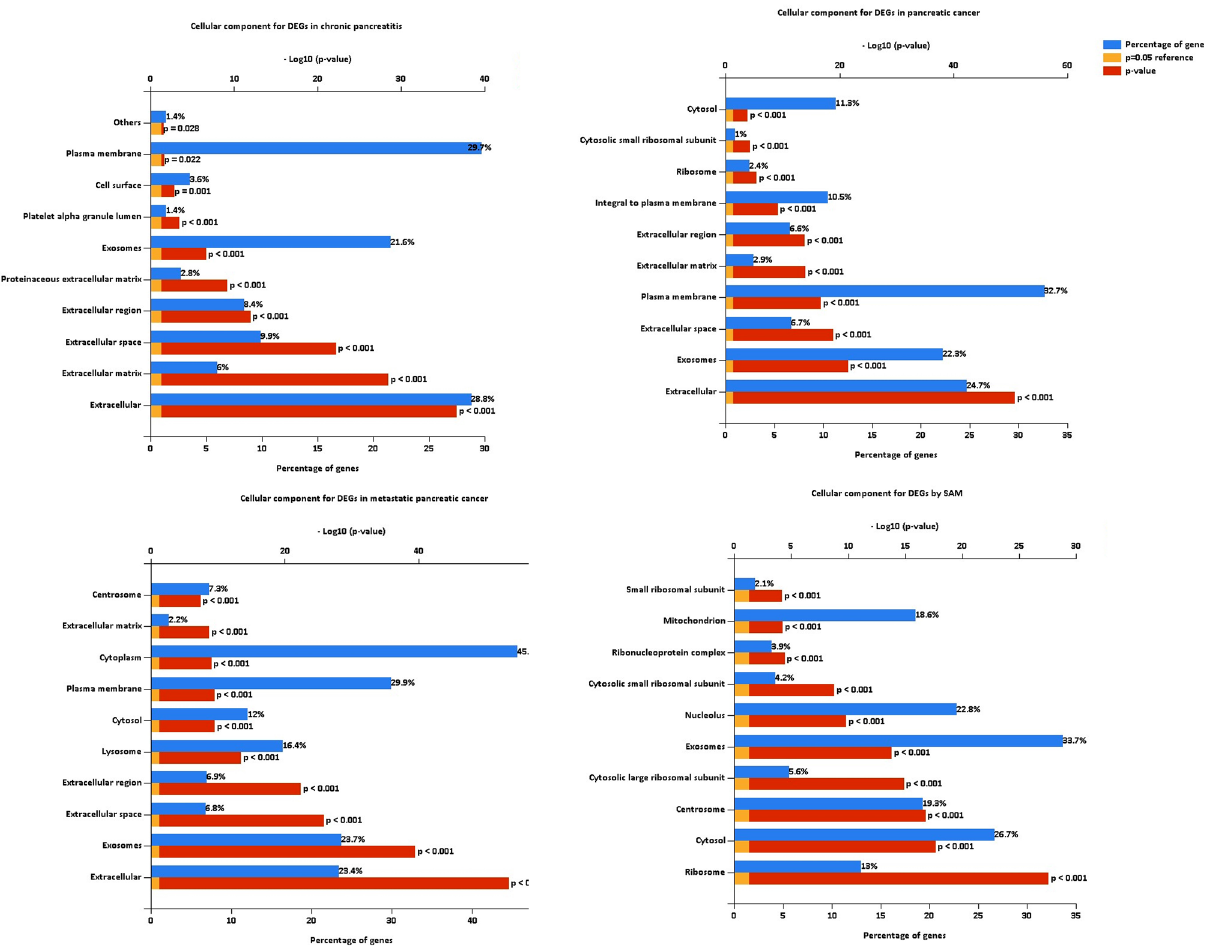
Figure 4. GO cell component for DEGs of chronic pancreatitis, pancreatic cancer, metastatic pancreatic cancer, and SAM,